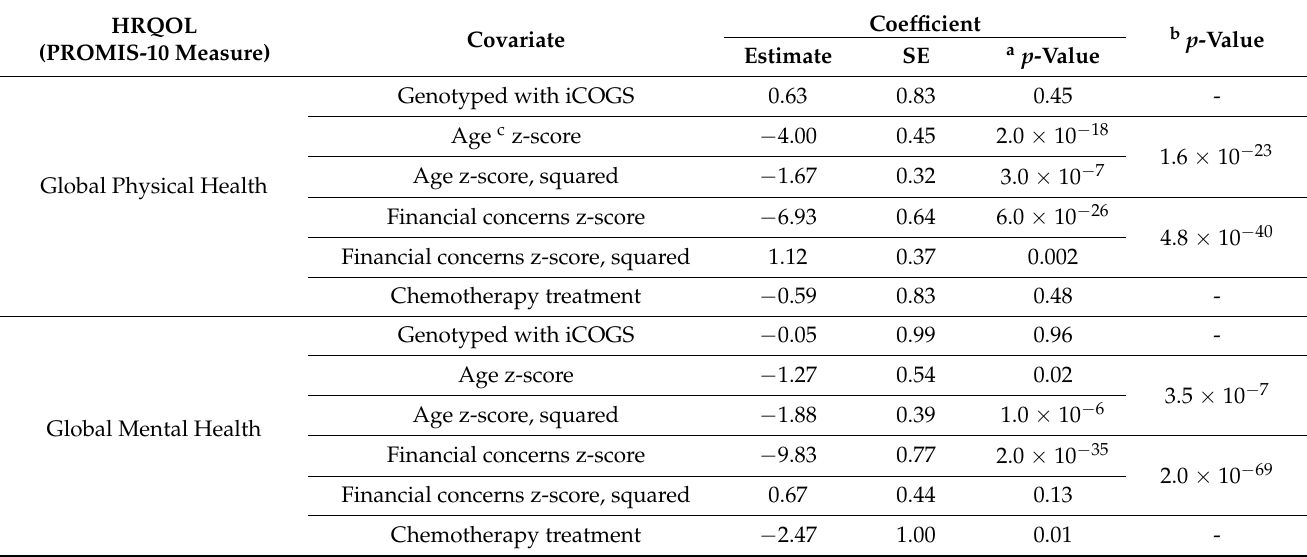
Table 2. Multivariable regression analysis: Factors related to HRQOL in the MCBDR.